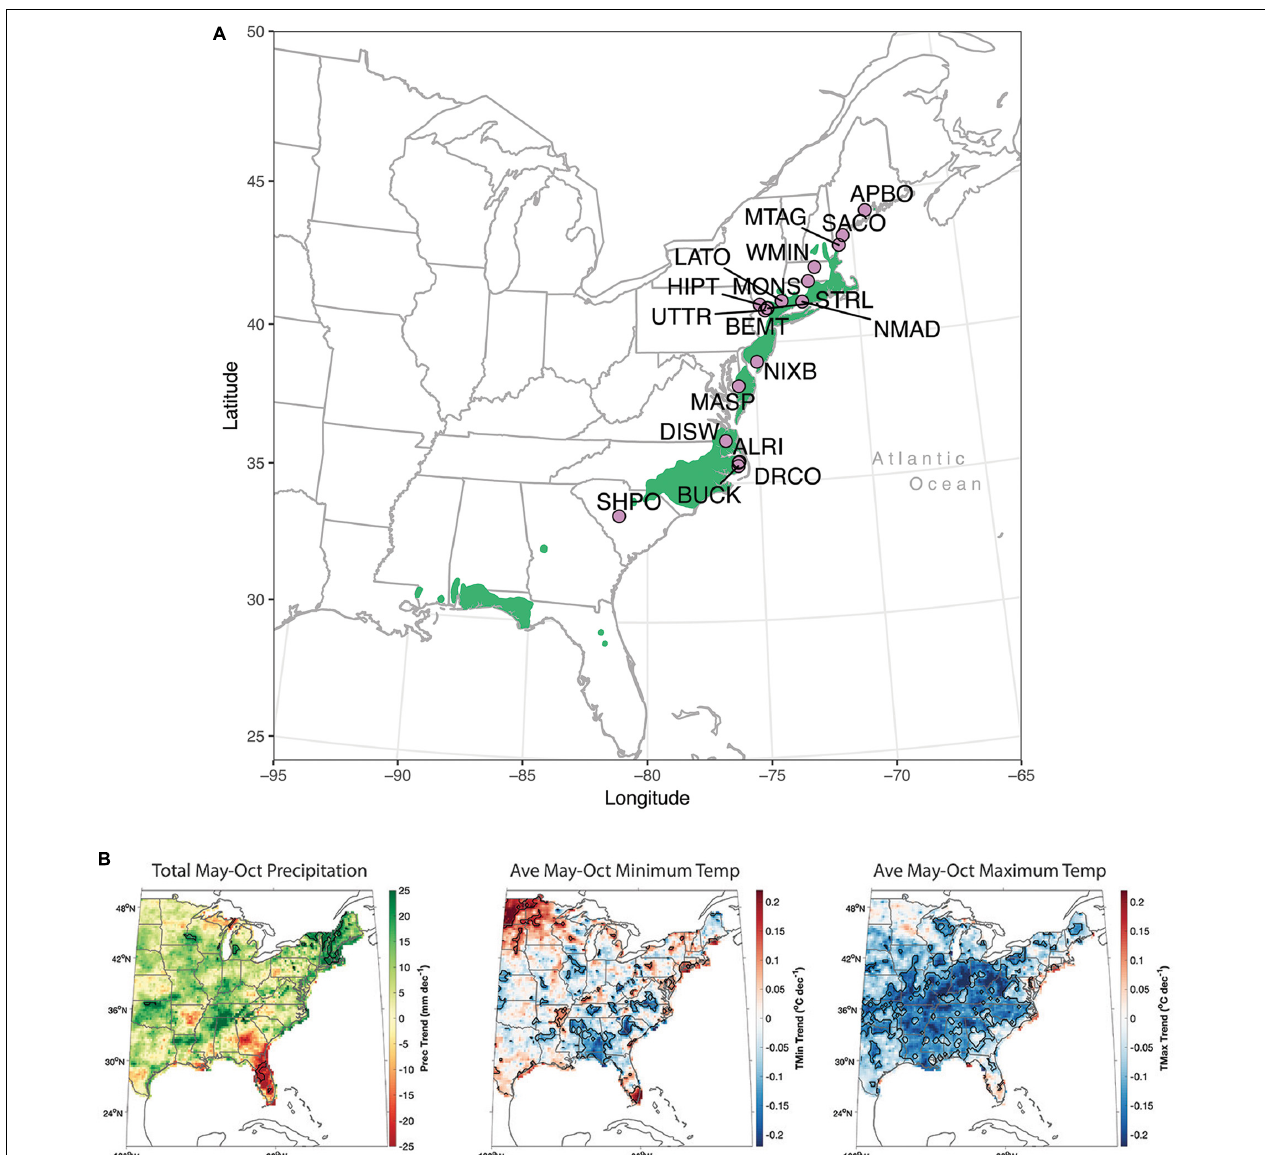
FIGURE 2 | (A) Network of 18 populations of Chamaecyparis thyoides (lavender circles) within its distribution (in green). Population names for each abbreviation are in Table 1 . (B) Linear trends in warm season (May-October) PRISM total precipitation, average monthly maximum, and minimum temperatures for the period of study,